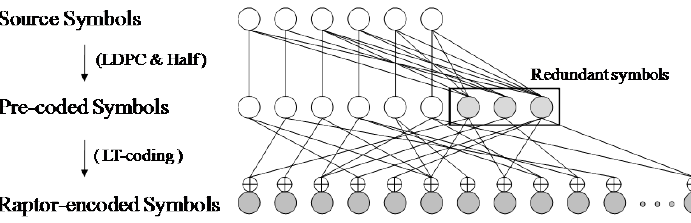
Figure 4. Two encoding steps of Raptor codes. LT, Luby transform; LDPC, low-density parity-check.